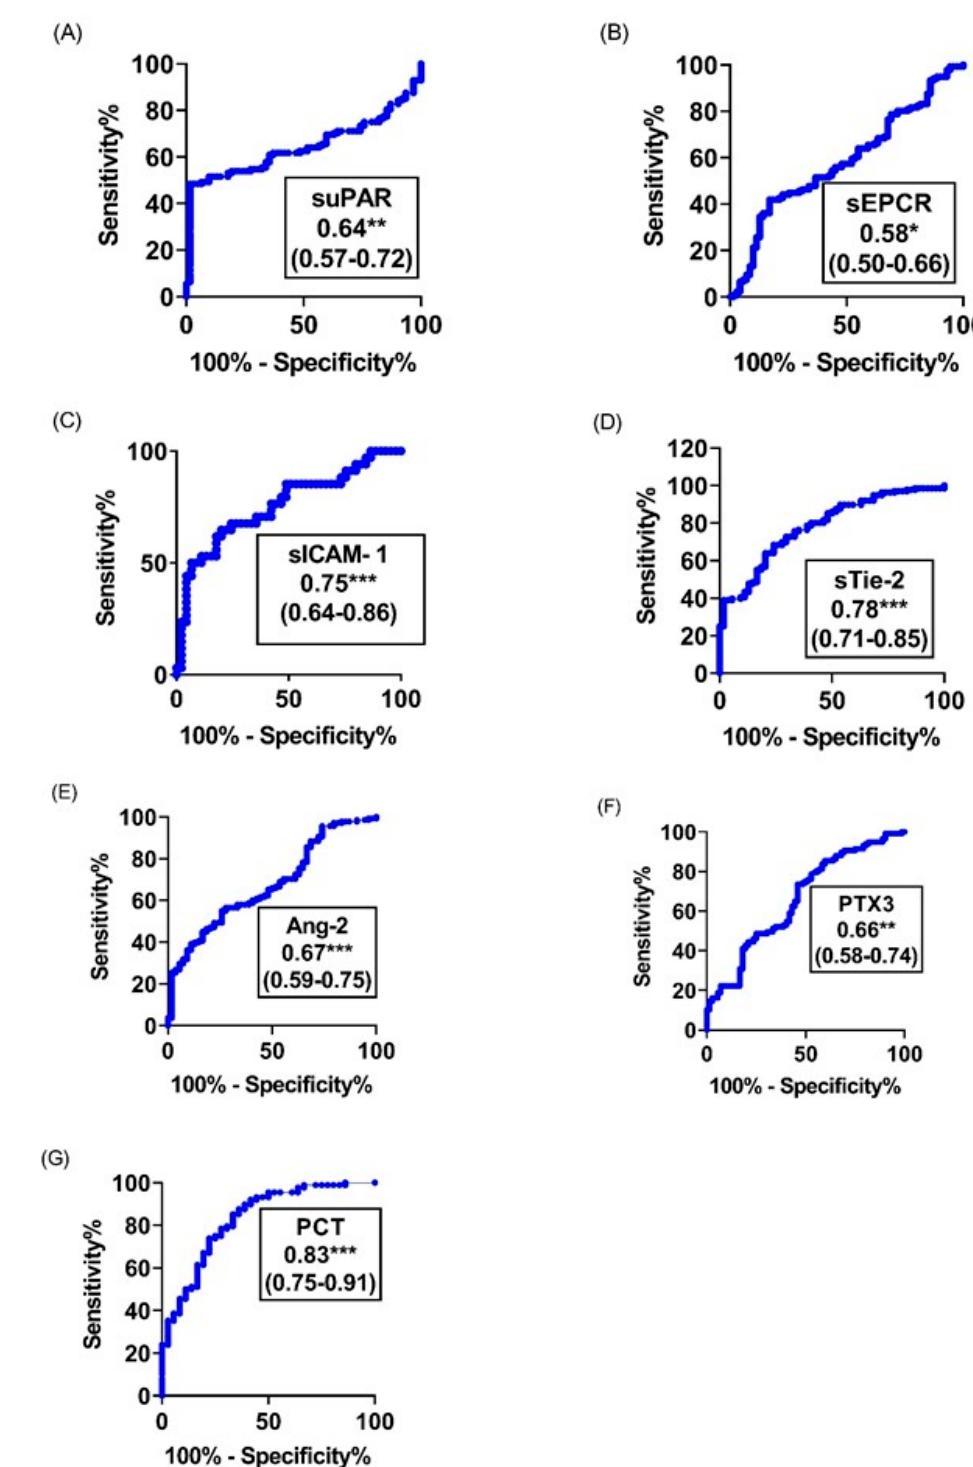
Figure 4. Assessment by ROC curve analyses of the individual prediction performance of PCT, sTie-2, Ang-2, PTX3, suPAR, sEPCR and sICAM-1 to differentiate severe from non-severe malaria cases. ( A – G ), Assessment by ROC curve analyses of the individual prediction performance of ( A ) suPAR, ( B ) sEPCR, ( C ) sICAM-1, ( D ) sTie-2, ( E ) Ang-2, ( F ) PTX3 and ( G ) PCT, to differentiate severe from non-severe cases on the day of admission to hospital. The area under the curve as well as the 95% confidence intervals are indicated in the legend. The * indicates 0.01 < p -value <0.05, ** 0.001< p value < 0.01, *** indicates p value ≤ 0.001.